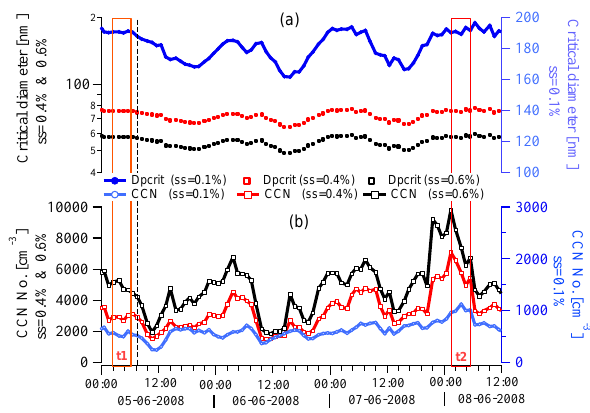
Figure 4. Critical diameter (Dpcrit) and CCN number concentration during NPF